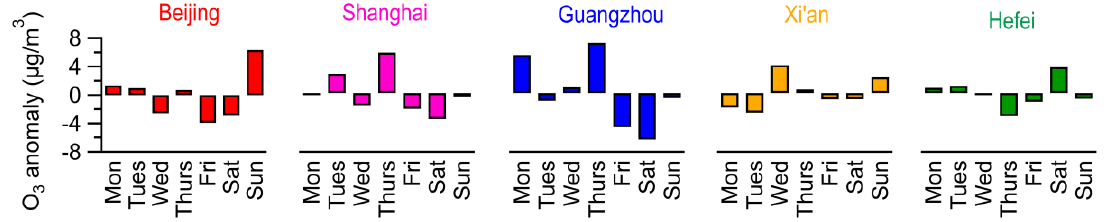
Figure 3. The weekly cycle of MDA8 O 3 concentration anomalies in the five cities.